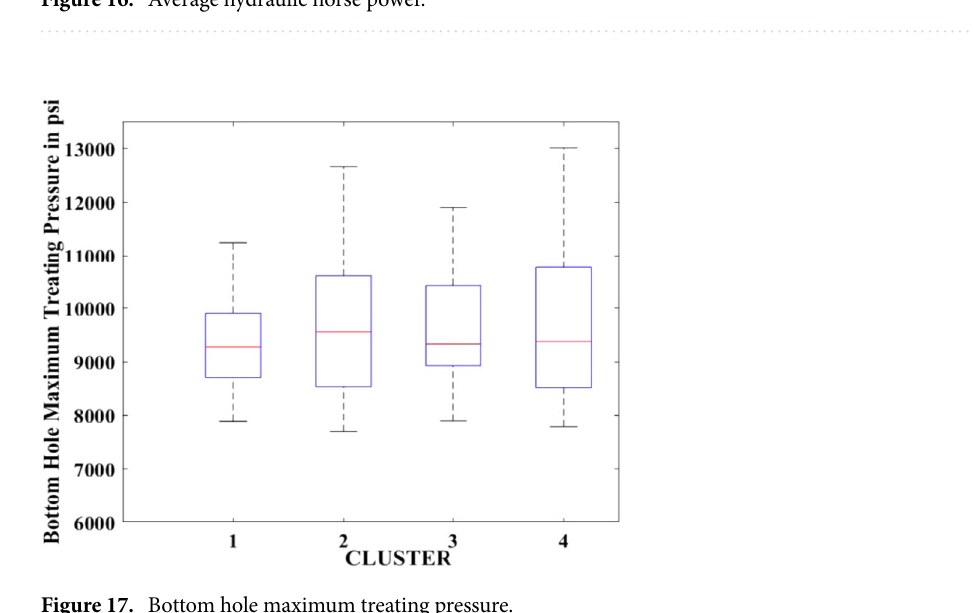
Figure 16. Average hydraulic horse power.